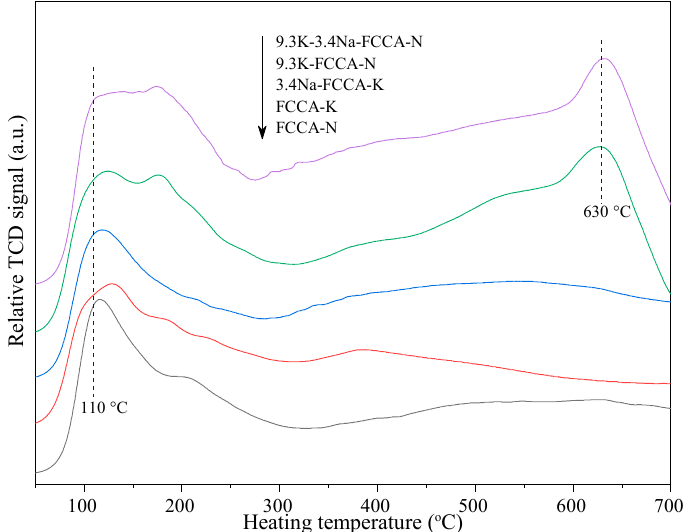
Figure 4. CO 2 -TPD curves of reduced FeCoCuAl catalysts before and after K and/or Na modification. Catalyst reduction at 400 °C for 1 h in pure H 2 .